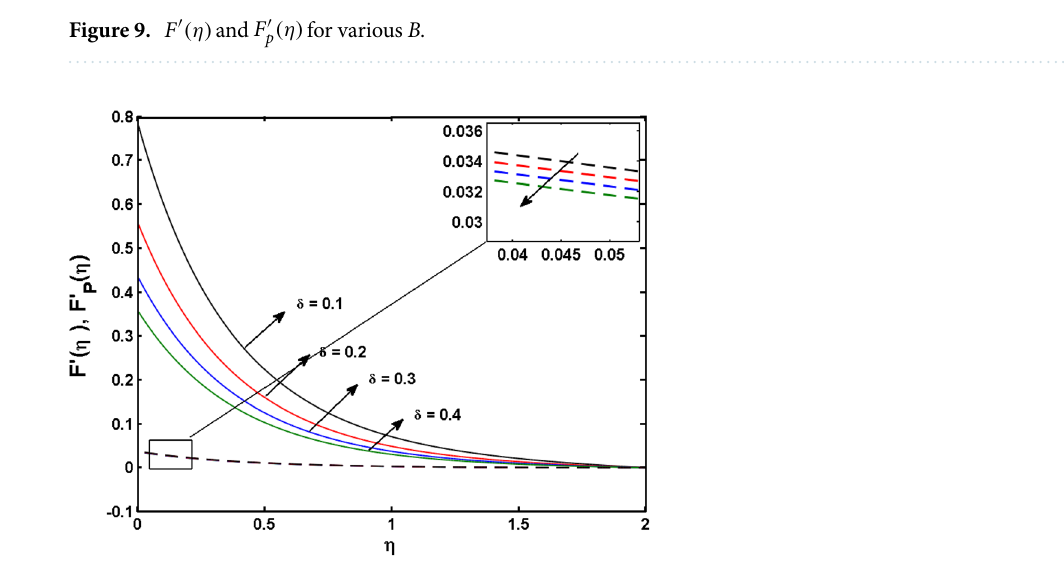
Figure 10. F ′ (η) and F ′ p (η) for various estimates of δ